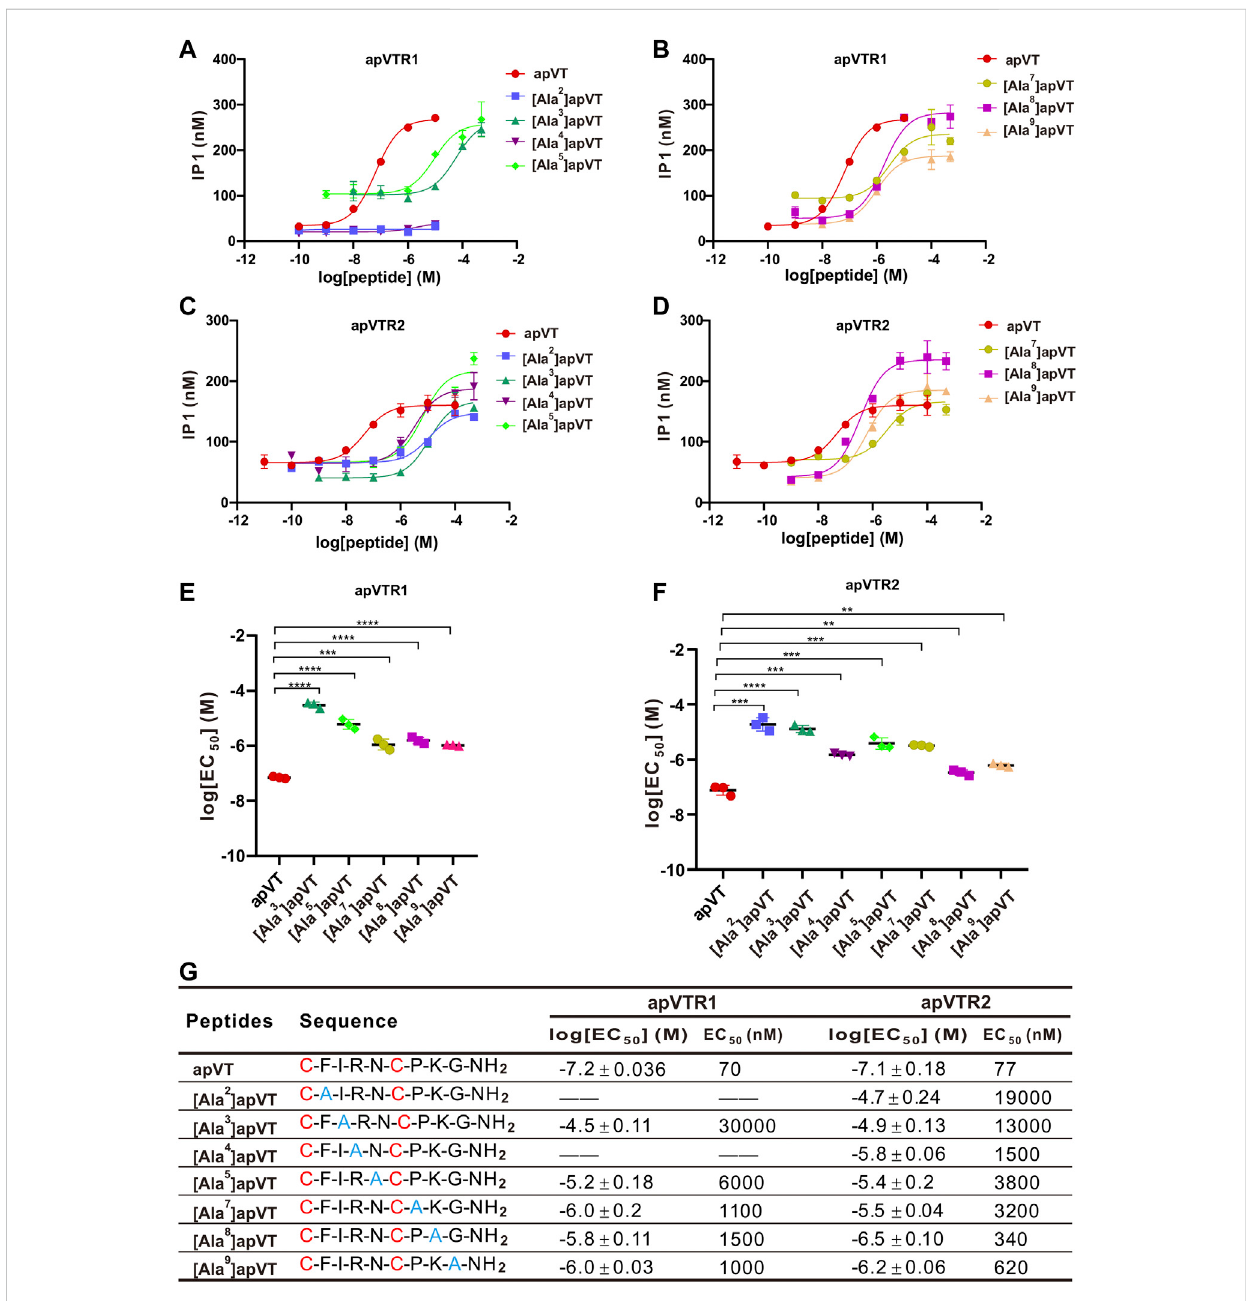
FIGURE 10 Activation of apVTRs by apVT analogs with alanine substitution. (A, B) Representative examples of dose-response curves of the activation of apVTR1bytheapVTanalogswithalaninesubstitution:[Ala 2 ]apVT,[Ala 3 ]apVT,[Ala 4 ]apVT,[Ala 5 ]apVT,[Ala 7 ]apVT,[Ala 8 ]apVT,[Ala 9 ]apVT;apVTwasusedasa control. (C,D) Dose-responsecurvesoftheactivation ofapVTR2byapVTanalogswithalaninesubstitution:[Ala 2 ]apVT,[Ala 3 ]apVT,[Ala 4 ]apVT,[Ala 5 ]apVT, [Ala 7 ]apVT, [Ala 8 ]apVT, [Ala 9 ]apVT; apVT was used as a control. (E) Comparison of log[EC 50 ] for apVTR1 by apVT and the fi ve apVT analogs ( n = 3 for each)shownin (A,B) .One-wayANOVA,F(5,12)=142, p < 0.0001. (F) Comparisonoflog[EC 50 ]forapVTR2byapVTandthesevenapVTanalogs( n =3for each)shownin (C,D) .One-wayANOVA,F(7,16)=93.92, p < 0.0001.Bonferroni posthoc test:**, p < 0.01;***, p < 0.001;****, p < 0.0001. (G) Sequences of apVT and all apVT analogs tested and summary of the average log[EC 50 ] and EC 50 on apVTR1 and